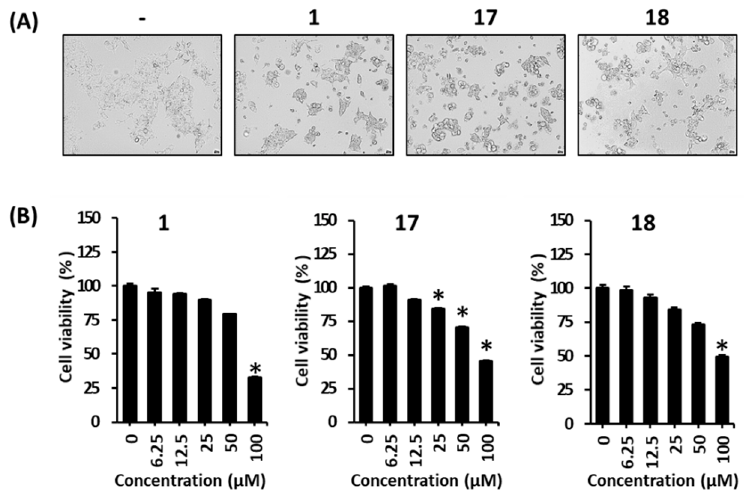
Figure 3. Cytotoxic effects of gallic acid ( 1 ), decursin ( 17 ), and decursinol angelate ( 18 ) in MCF-7 cells exposed to 6.25, 12.5, 25, 50, and 100 µ M of each compound for 24 h. ( A ) Viability of MCF-7 cells. ( B ) Morphological changes in MCF-7 cells. The data are presented as the mean ± S.D. and were analyzed using a one-way analysis of variance (ANOVA) and a Dunnett’s multiple comparisons post hoc analysis. * p < 0.05 versus untreated cells.